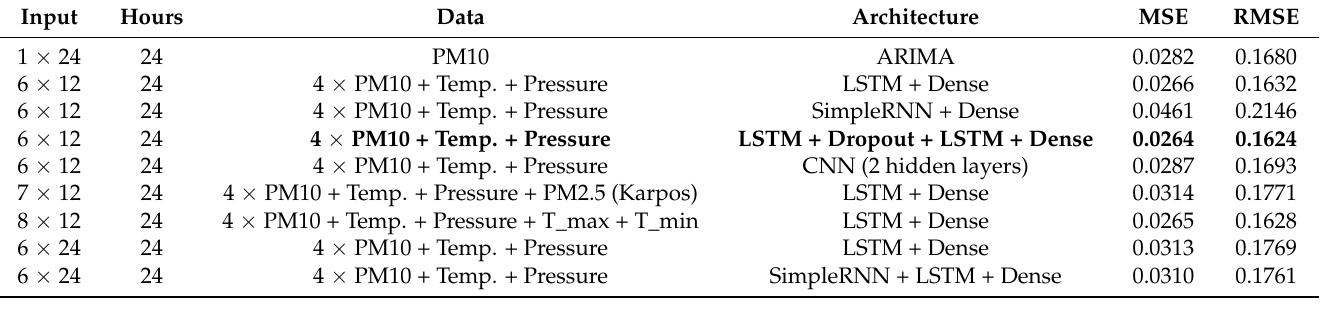
Table 6. Summary of the evaluated approaches with the achieved average forecasting performance in terms of the Mean Squared Error (MSE) and Root Mean Squared Error (RMSE) for the 24 h time horizon. The best performance is marked in bold.